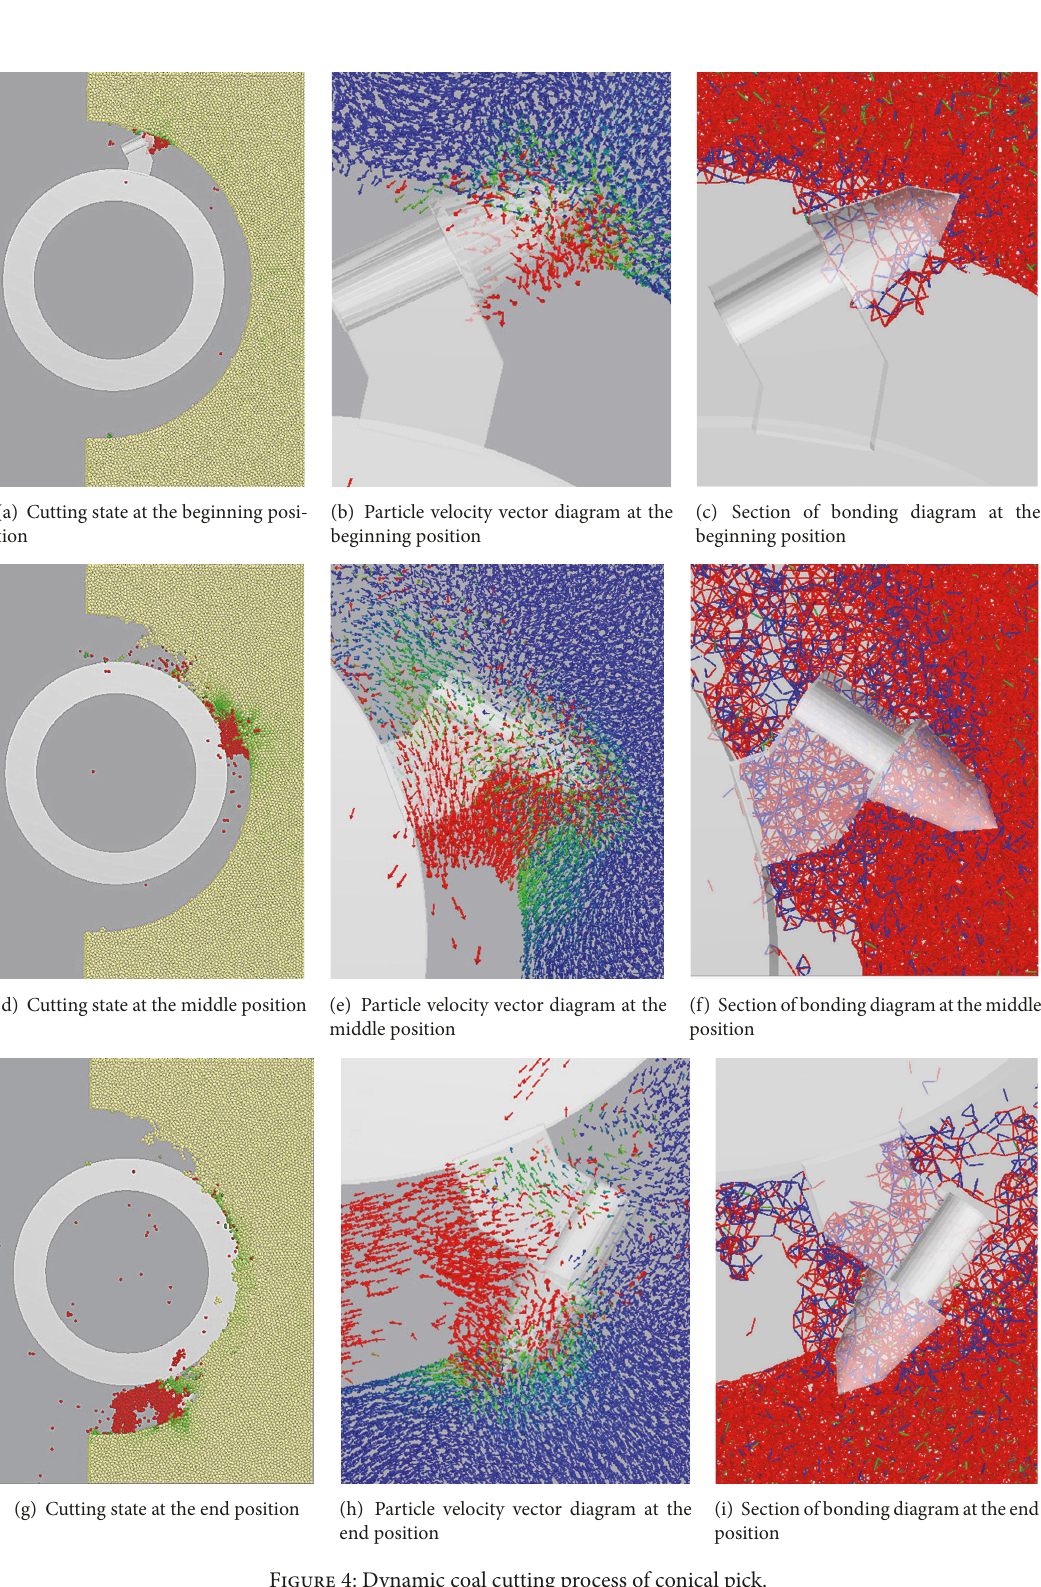
Figure 4: Dynamic coal cutting process of conical